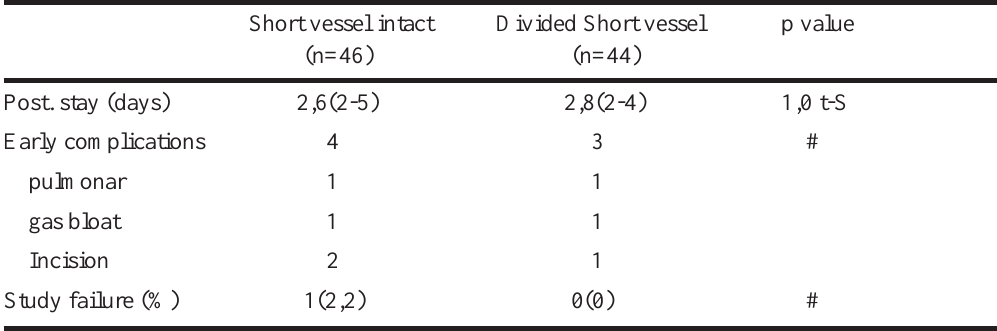
Short vessel intact